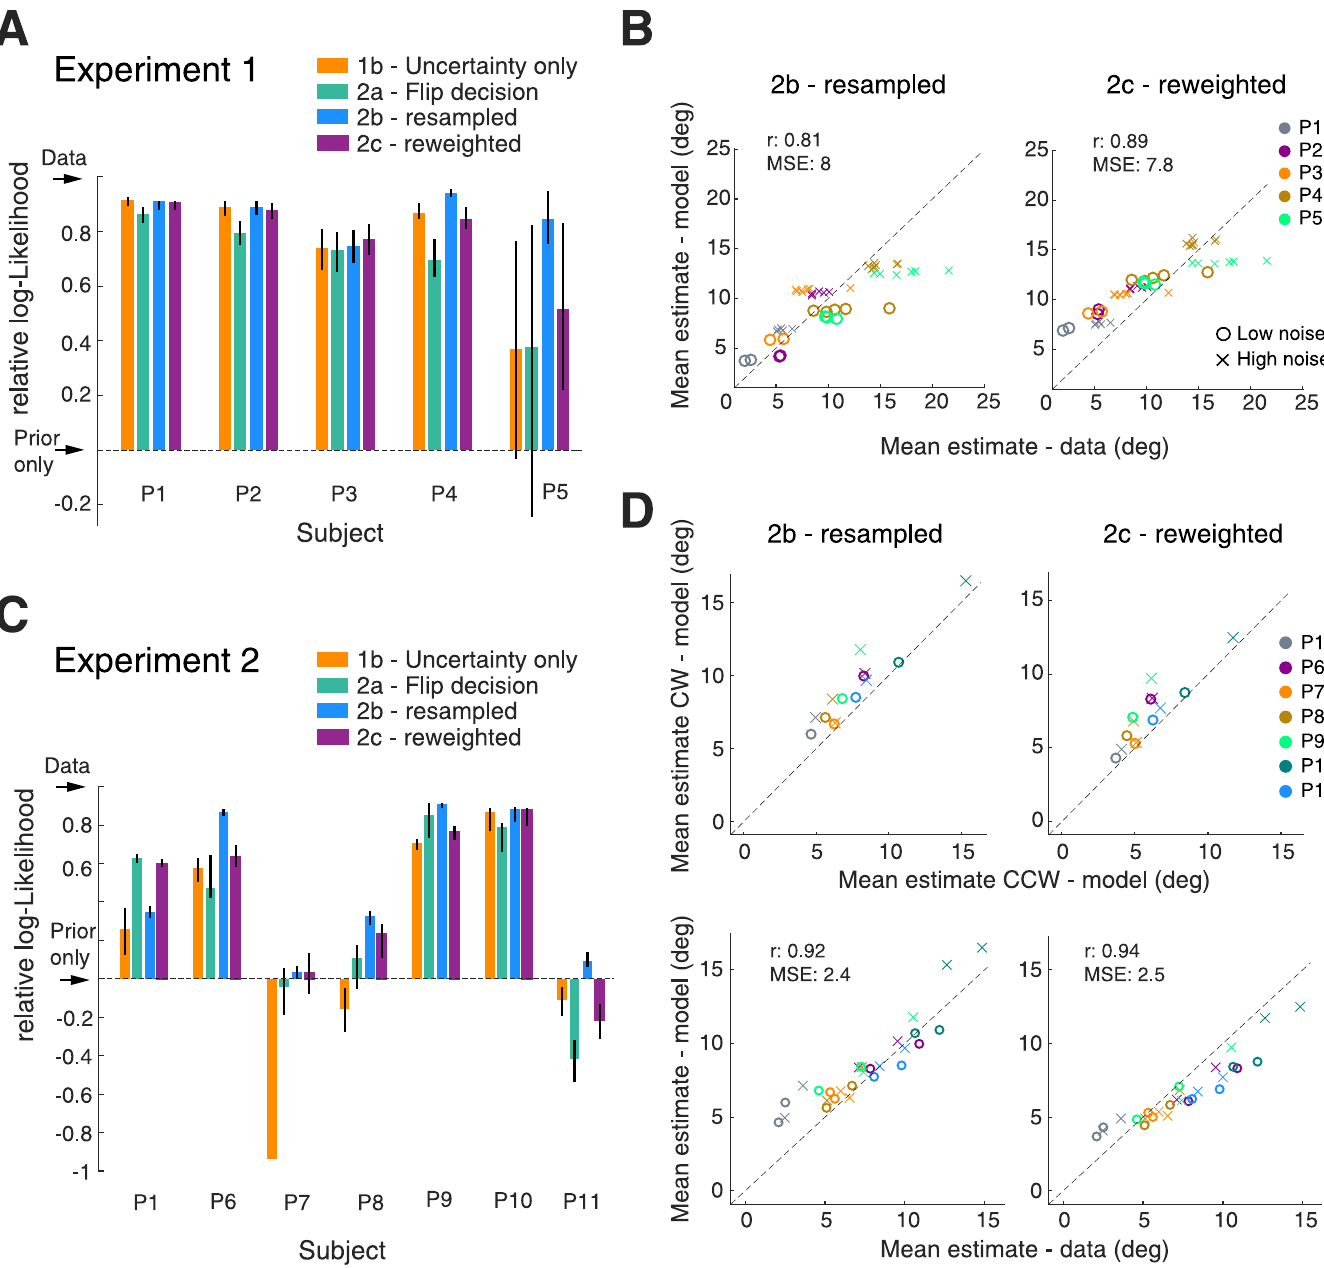
Fig 11. Performance of Models 2b (resampled) and 2c (reweighted). (A) Normalized log-likelihood comparison for Experiment 1. All models perform well compared to Model 1a (prior only), confirming that subjects maintain and reuse information about stimulus uncertainty on a per trial basis. Models 2b and 2c, however, perform consistently better than Model 2a. (B) Both models better predict subjects’ mean estimates than Model 1b (MSE and correlation; see Fig 5C). Predictions of Model 2c show a similar deviation from the data as the predictions of Model 2a. (C) Normalized log-likelihood comparison for Experiment 2. Model 2b consistently, but not always significantly, best predicts the data except for P1 (non-na ï ve). (D) In contrast to Model 1b, Models 2b and 2c both correctly predict mean estimates higher on the cw than the ccw side (see Fig 8B). Correlation and MSE measures indicate little difference between Model 2b and 2c; their predictions are better than those of Model 1b and 2a (see Fig 8C). All model predictions are parameter free and based on the parameter values of the fit self-consistent observer model to the data in correct trials. Errorbars indicate 95% confidence intervals computed from 200 bootstrapped samples.